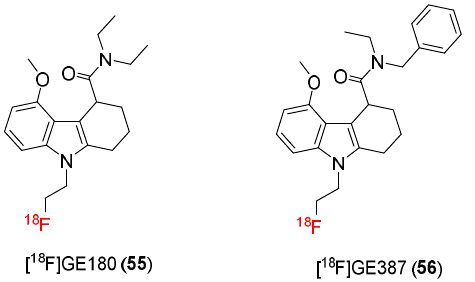
Figure 8. Structures of TSPO ligands containing tricycle indole.